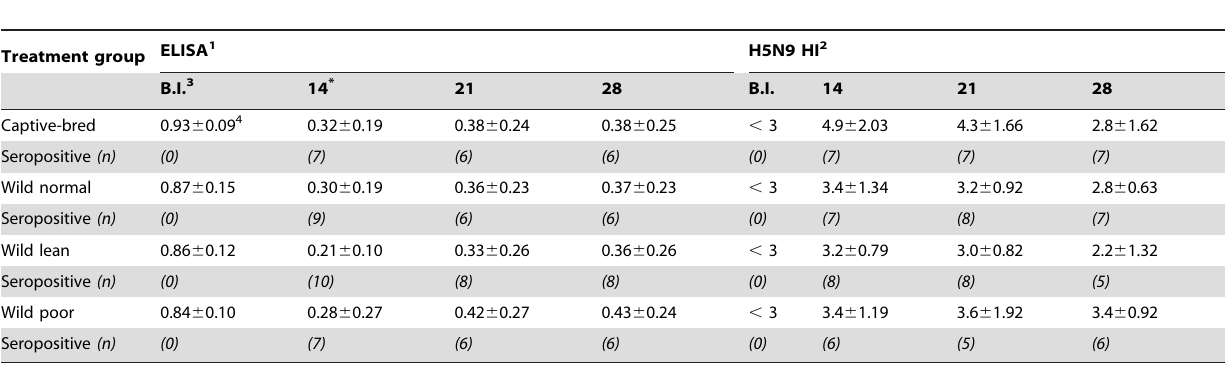
* Bold numbers indicate days after LPAIV H5N9 inoculation. 1 The ELISA scores represent the signal to noise (S/N) ratio where values # 0.50 are considered seropositive. 2 The hemagglutination inhibition (HI) values represent the mean titer (log 3 Before LPAIV H5N9 inoculation. 4 Mean ( 6 1 SD) test scores include all infected birds in each treatment.